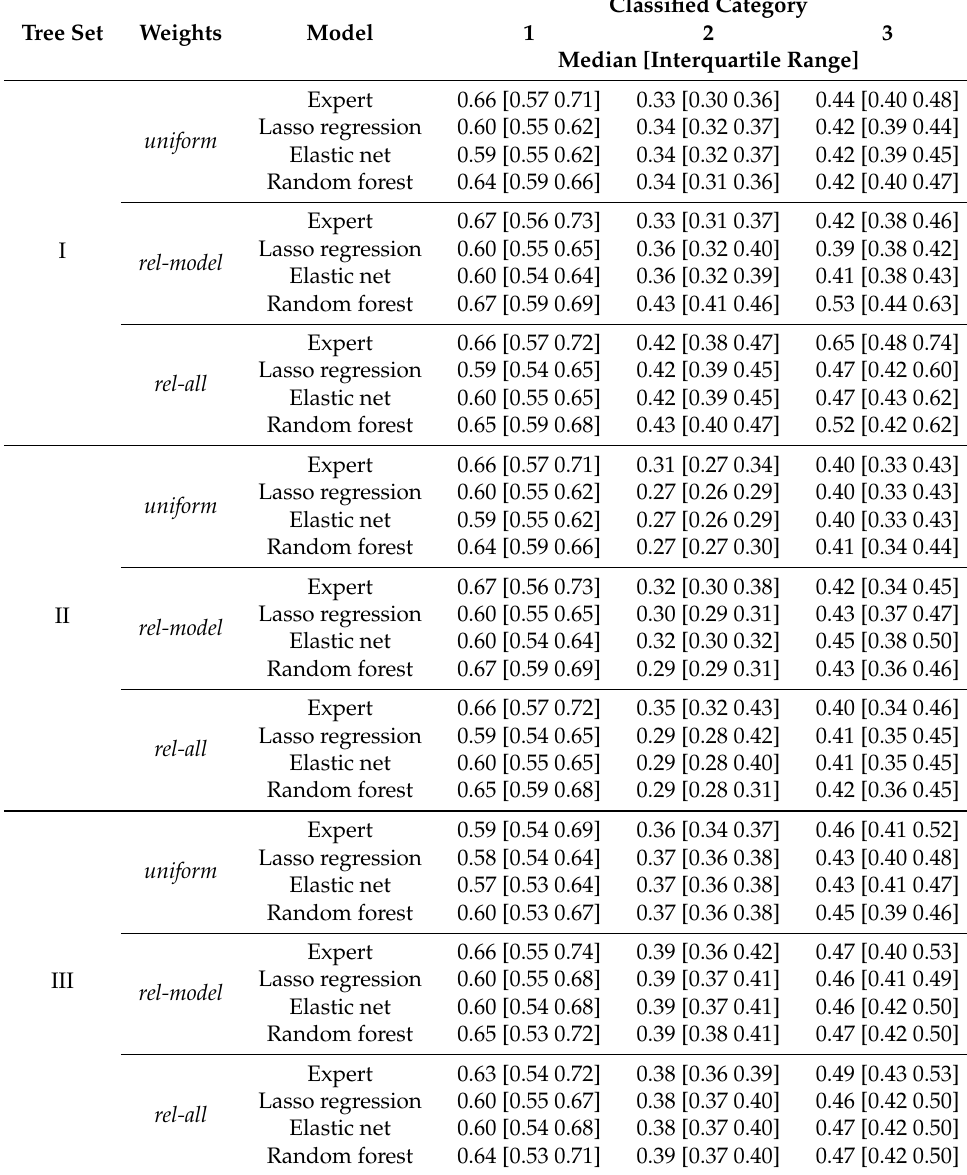
Table A2. Certainty (median and interquartile range) for all tree sets and weights. For each weight, the data are organized as in Figure 10. Category numbers correspond to the respective categories of each tree